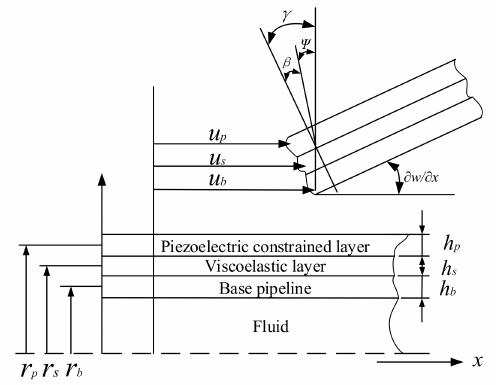
Figure 2. Deformation of the ACLD